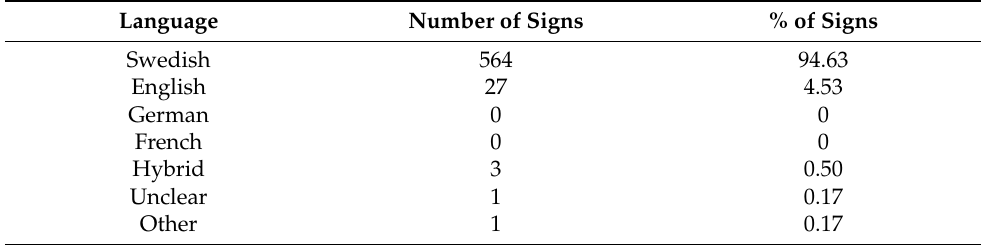
Table 3. Languages on monolingual signs (N =